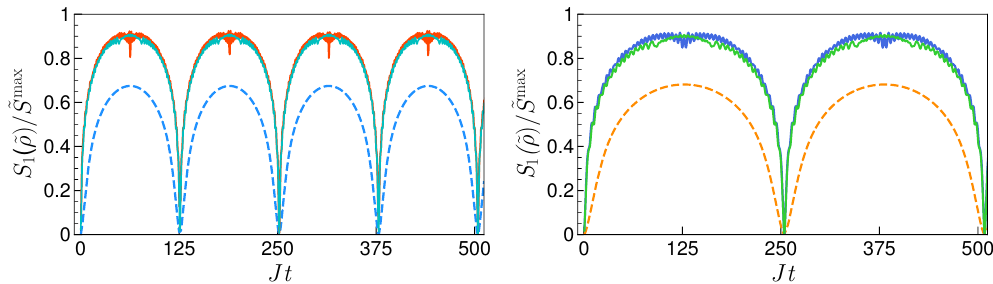
Figure 8: Entanglement dynamics under the effective Hamiltonian. Dimensionless units are used. We set J = 1 and N = 60. The left panel is for U = 0.17, l = 0 and initial states : | 60,0,0 〉 (dashed blue line), | 40,0,20 〉 (cyan line) and | 30,0,30 〉 (thicker red line). The right panel is for U = 0.7, l = 9 and initial states: | 51,9,0 〉 (dashed orange line), | 36,9,15 〉 (green line) and | 26,9,25 〉 (thicker blue line). ] = i ε satisfying the commutation relations [ , abc J c J a J b